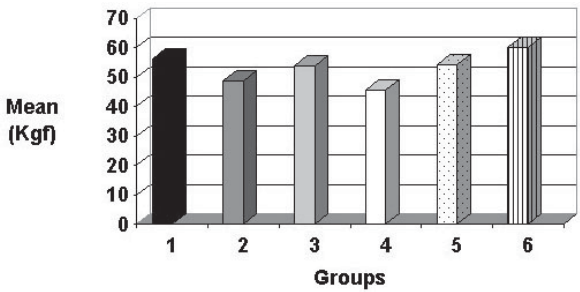
FIGURE 2- Graph representing the mean fracture strength values of the study groups